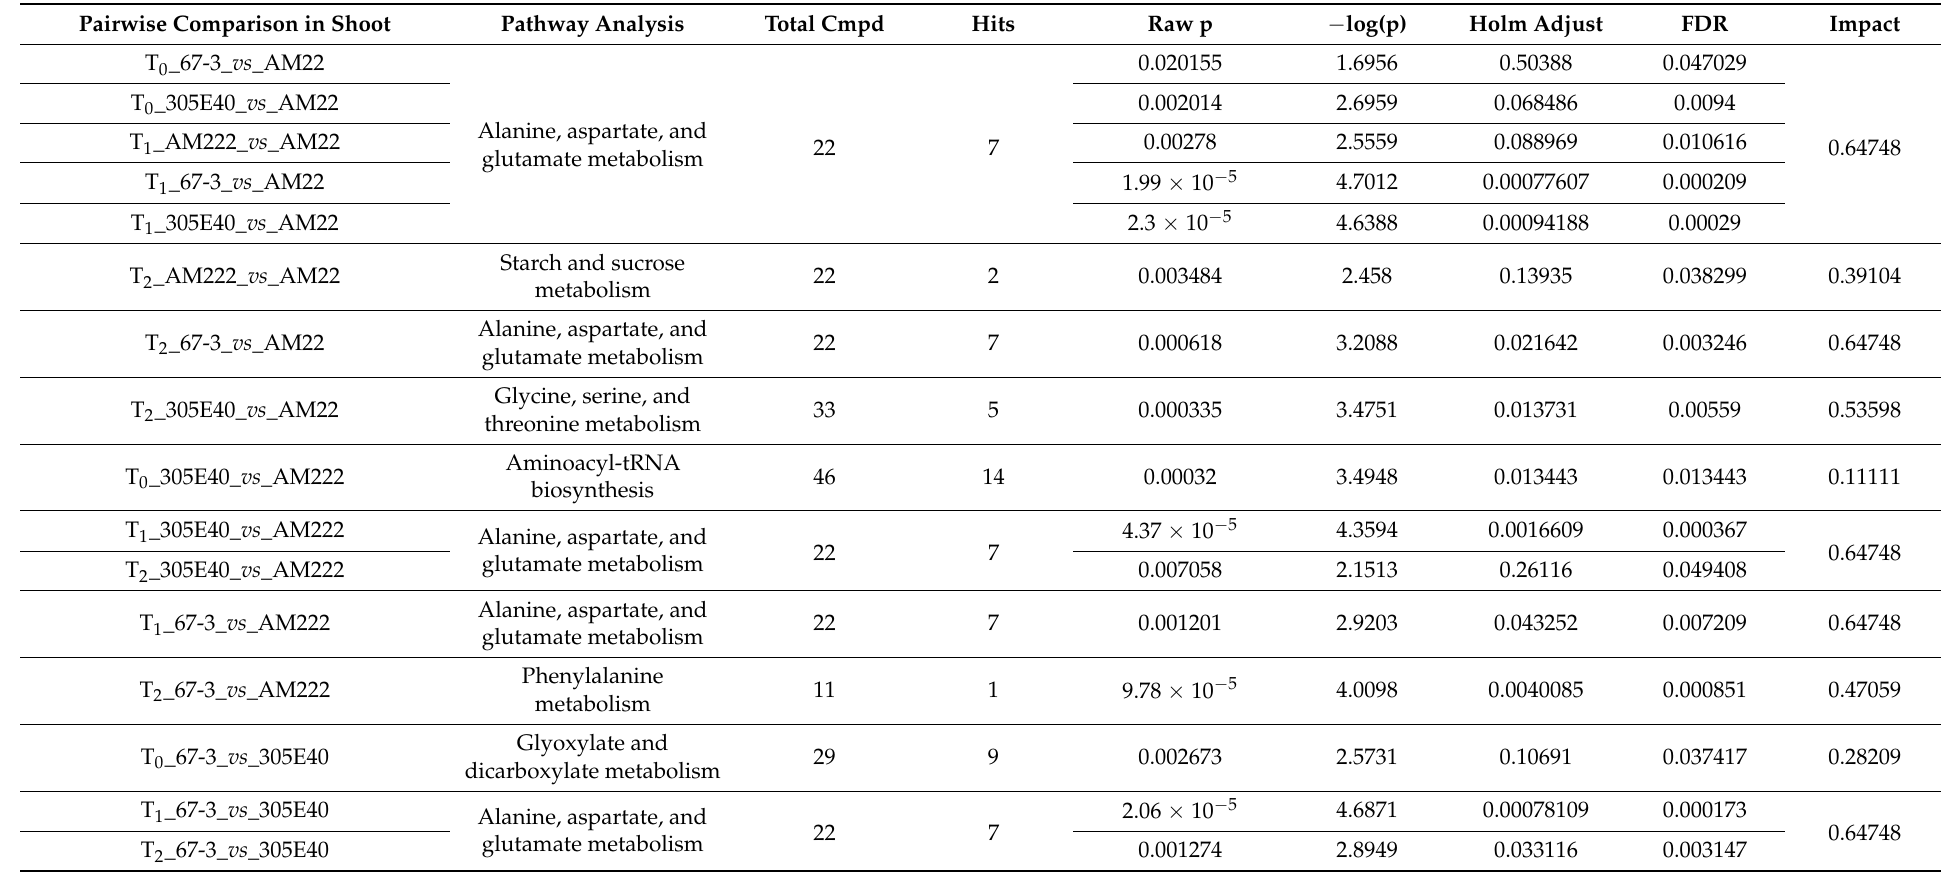
Table 1. Comparative changes in the primary metabolite pathways in shoot. Metabolic pathways with FDR < 0.05 and higher impact values are highlighted. Pairwise comparison between genotypes. Total Cmpd represents the total compound number in the pathway; Hits is the actual matched number from the uploaded data; Raw p is the original p value calculated from the enrichment analysis; Holm p is the p value adjusted by Holm–Bonferroni method; FDR p is the p value adjusted using false discovery rate; Impact is the pathway impact value calculated from pathway topology